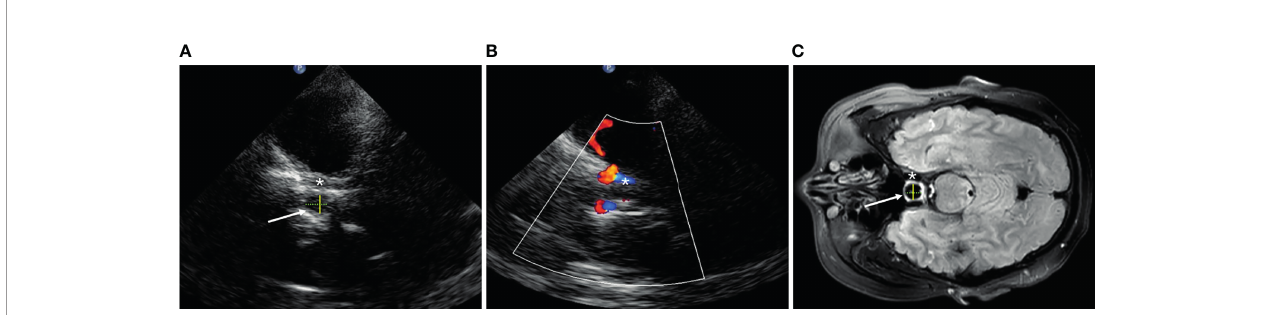
FIGURE 1 | The structure of Sella turcica (arrow) in transcranial sonography (A, B) and MRI (C) . Asterisk, cavernous segment of the internal carotid artery; yellow solid line, D1; green dotted line,